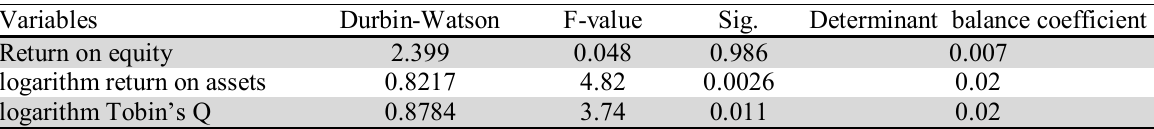
The statistic of Durbin-Watson and F- statistics Variables